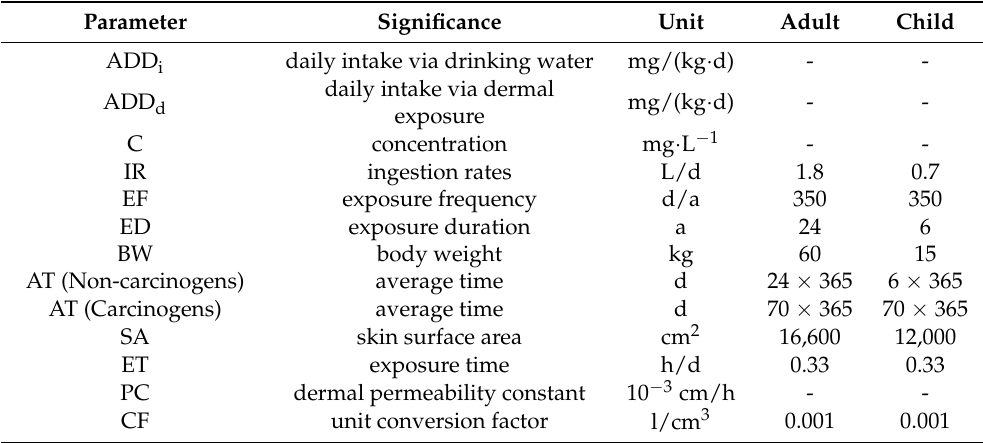
Table 2. Parameters of groundwater health risk assessment